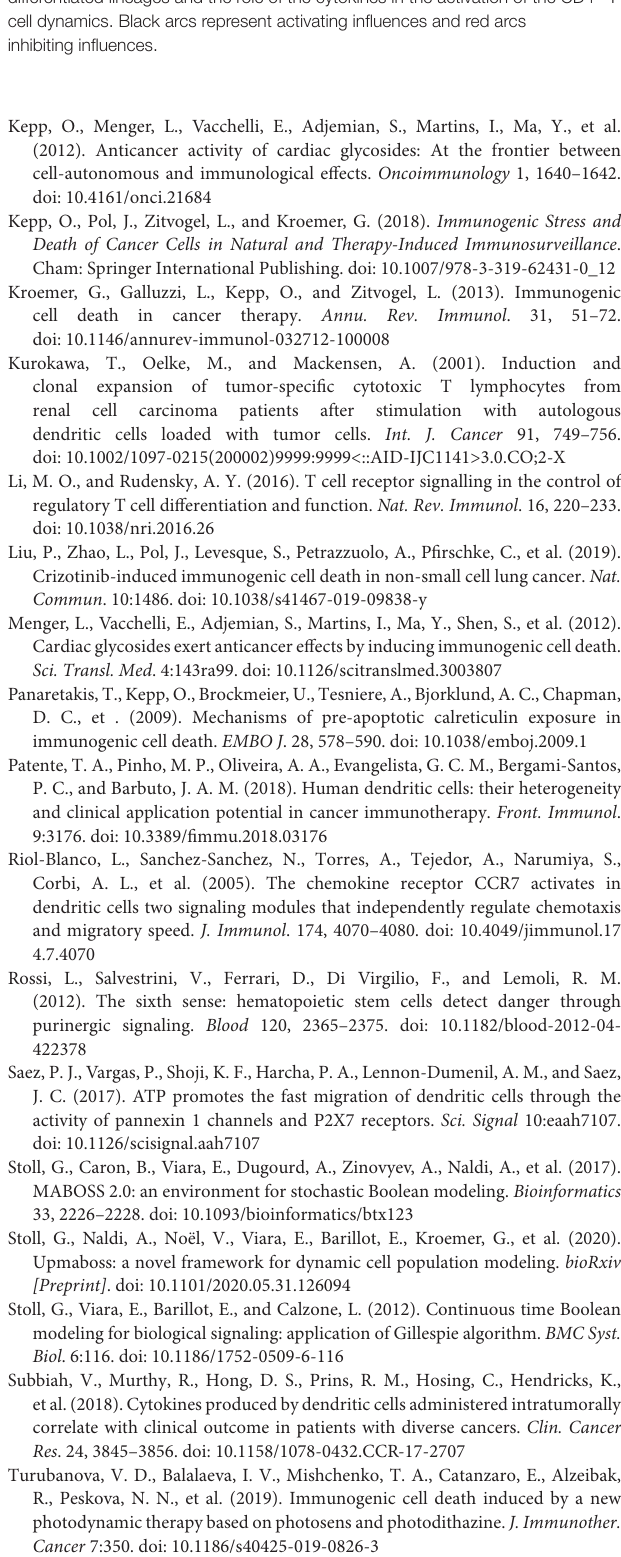
Supplementary Figure 1 | Ligand-receptor dynamics related to dendritic cells. DC shows receptors (blue nodes) on its surface (dashed arcs) that can interact with ligands (orange nodes) and can then release ligands (pink nodes).